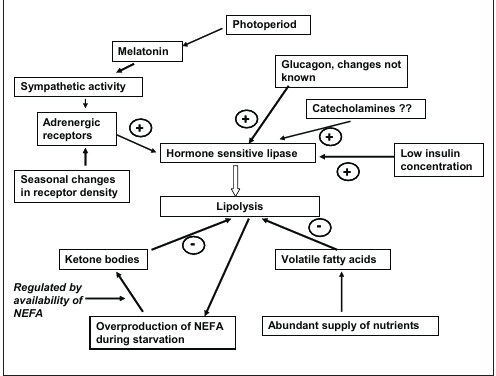
Fig. 4. Regulation of hormone sensitive lipase (HSL) and lipolysis in adipose tissue. + indicates a factor that increases the activity of HSL and – indicates